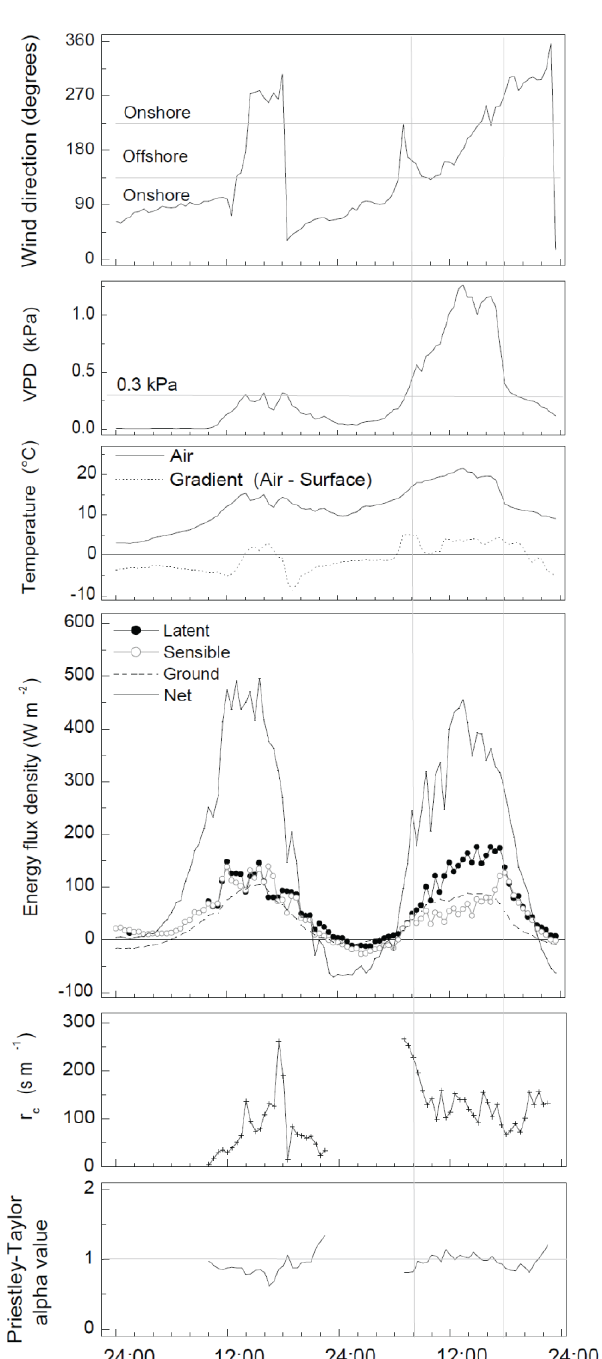
Fig. 7. Meteorological conditions, energy balance, and bulk param- eters during a two-day time period (22 and 23 July 2000), when the wind shifted from onshore to offshore. The high VPD on 23 July coincides with offshore winds. Latent heat became the dominant heat sink when air vapor pressure deficit reached above